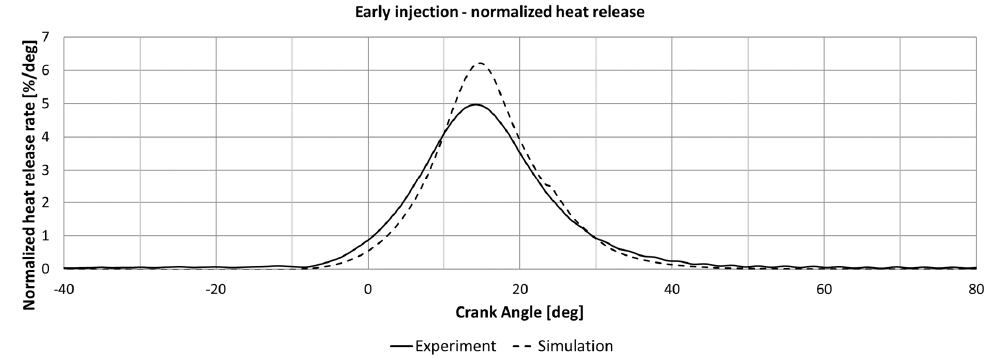
Figure 13. Measured and simulated heat release rates, early injection Figure 3. Measured and simulated heat release rates, early injection timing.